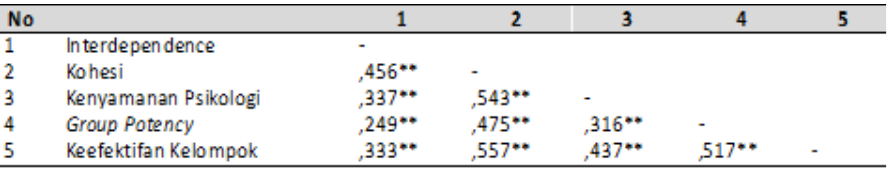
Tabel 1. Hasil interkorelasi Spearman rank (n = 223)